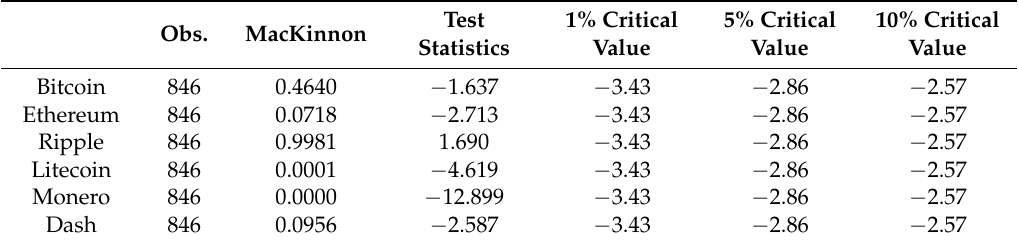
Table 5. Augmented Dickey-Fuller unit root test for the cryptocurrencies.